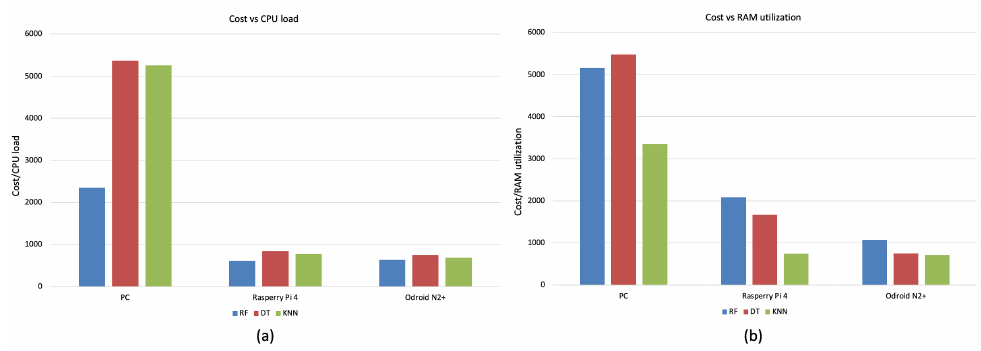
Figure 6. Average power consumption (W) of rest phase and of each classifiers on the embedded